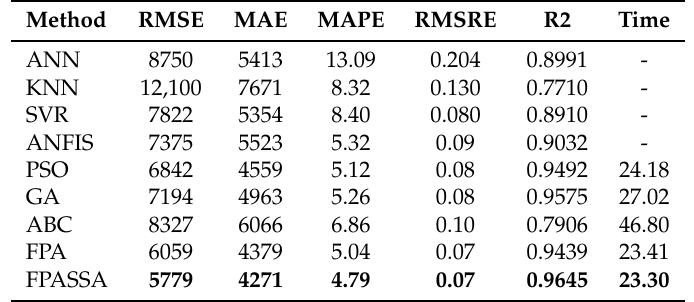
Table 4. Computational results for COVID-19.